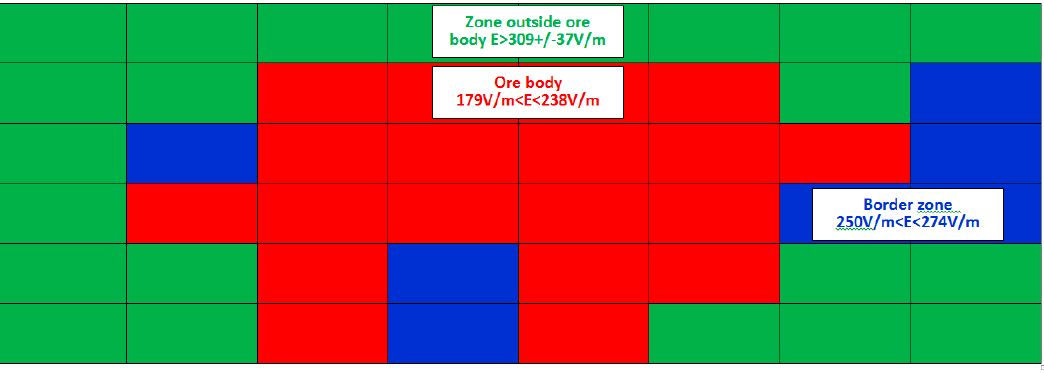
Figure 2. Some examples of variations of AEF over ore-body in